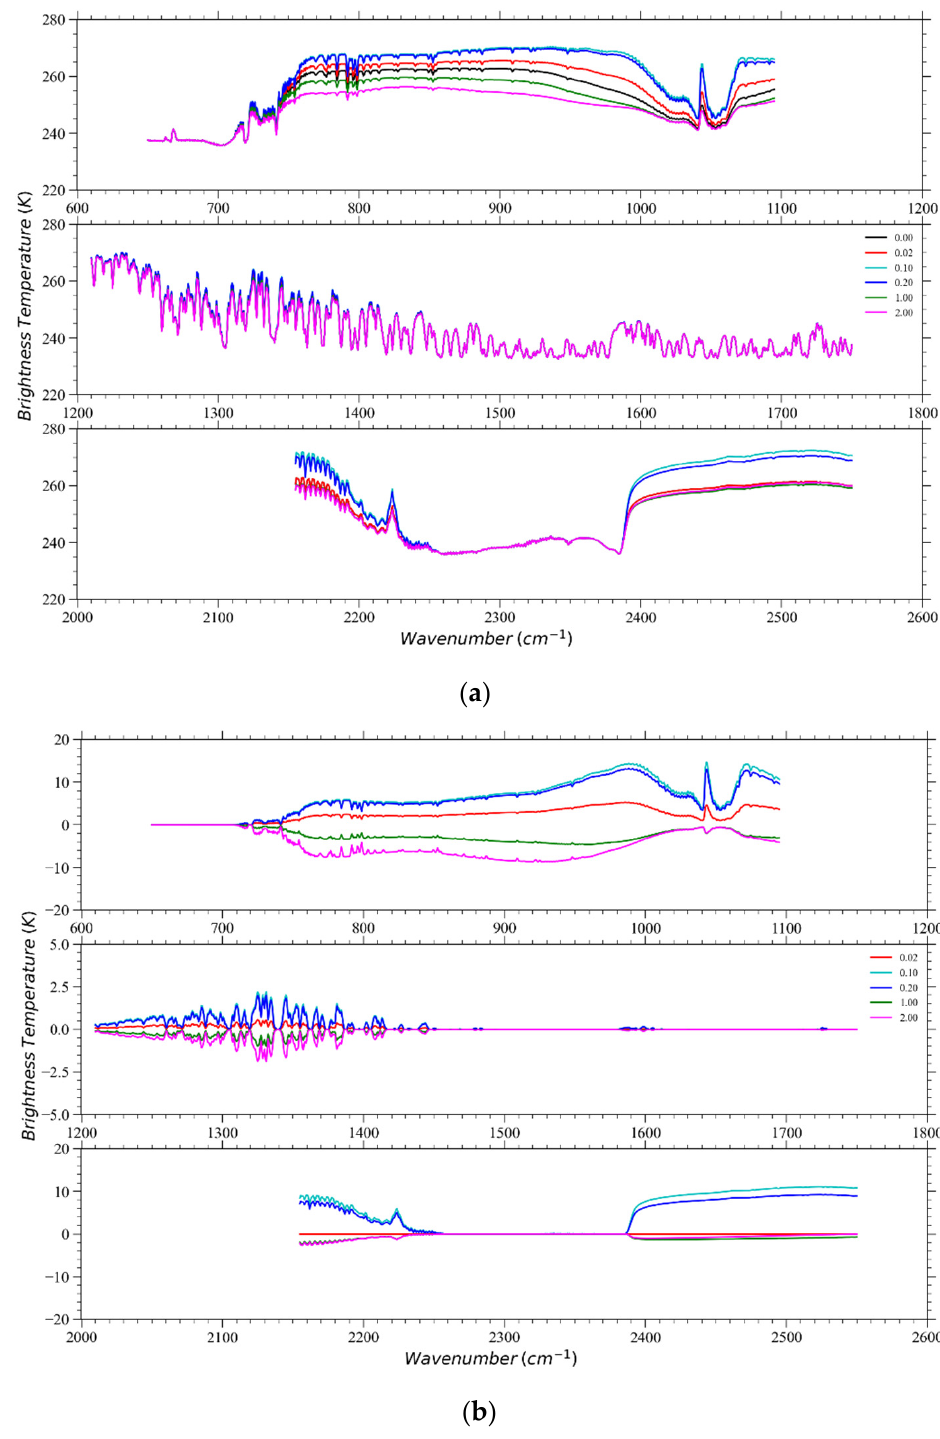
Figure 4. The same as Figure 3 except for scaling of the effective radius (shown in Figure 1e) of the sand aerosol profile. ( a ) Simulated brightness temperatures. ( b ) difference between the clear condition and scaling of the effective radius